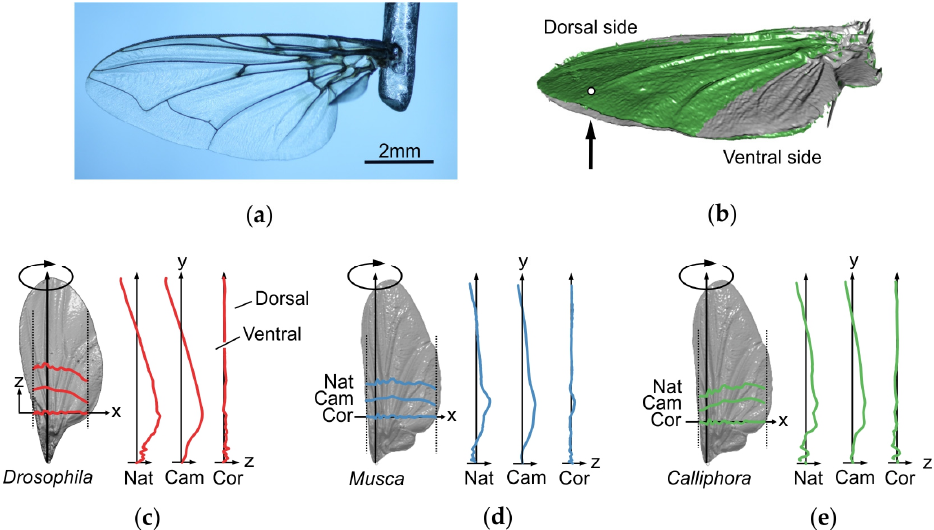
Figure 1. Characteristics of fly wings. ( a ) Detached wing of the blowfly Calliphora vomitoria , mounted to a steel holder. ( b ) Deformation of a blowfly wing (green) during loading by a ~64 µN point force (white dot) applied normal to the ventral wing side (arrow) [75] . Grey, surface profile without load. ( c – e ) Spanwise and chordwise wing profiles along the axes of rotation in three differently-sized fly species ( Drosophila melanogaster , Musca domestica , Calliphora vomitoria ). The wing profiles are superimposed on natural wing models (grey). The profiles separately show wing camber (Cam) and wing corrugation (Cor). Both wing components were numerically extracted from the natural wing exaggerated by a factor of 2 for better